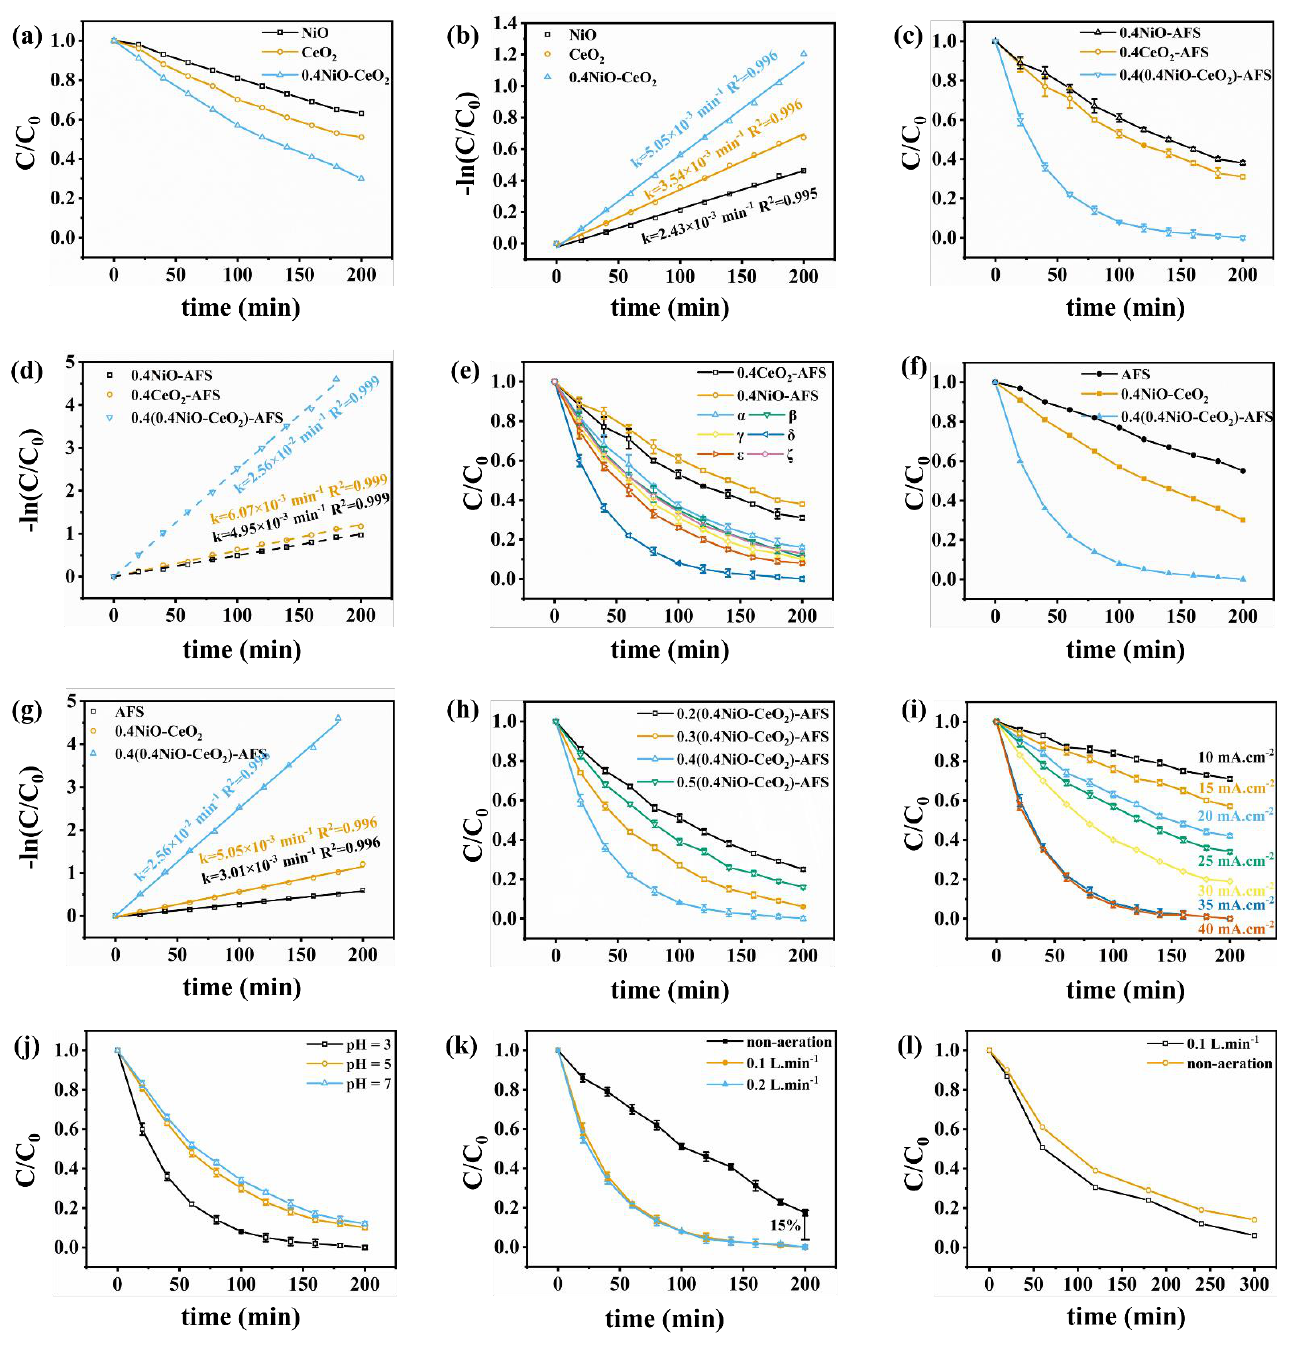
Figure 5. Degradation curves ( a ) of TC and corresponding pseudo-first-order kinetic curves ( b ) for NiO, CeO 2 , and 0.4NiO − CeO 2 . The degradation curves ( c ) of TC and kinetic curves ( d ) for 0.4NiO − CeO 2 , 0.4CeO 2 − AFS, and 0.4(0.4NiO − CeO 2 ) − AFS. The degradation curves ( e ) of TC by a series of samples (α − ζ are y values from 0.1 to 0.6 in 0.4(yNiO − CeO 2 ) − AFS). The degradation curves ( f ) of TC and kinetic curves ( g ) for AFS, 0.4NiO − CeO 2 , and 0.4(0.4NiO − CeO 2 ) − AFS. The degradation curves ( h ) of TC for x(0.4NiO − CeO 2 ) − AFS ( x = 0.2 – 0.5). The degradation curves of TC by 0.4(0.4NiO − CeO 2 ) − AFS under different current densities ( i ), pH ( j ), and aeration velocity ( k ). The TOC removal curves ( l ) of TC by 0.4(0.4NiO − CeO 2 ) − AFS in 300 min under different aeration velocities. (Standard experimental conditions: [TC] = 200 ppm; pH = 3; 35 mA/cm 2 ; and 0.1 L/min.).